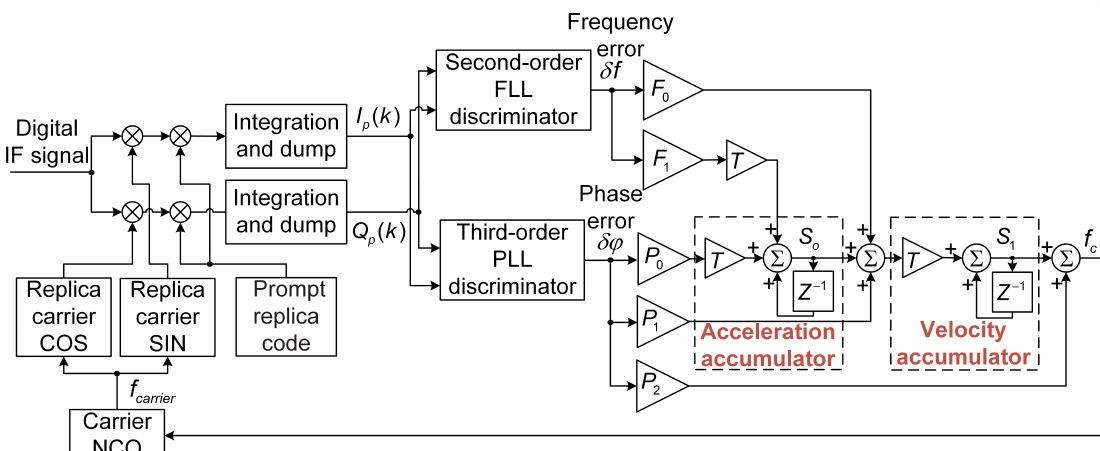
Figure 3. Block diagram of the second-order FLL assisting third-order PLL tracking loop. (NCO: numerically controlled oscillator; FLL: frequency-locked loop; PLL: phase-locked